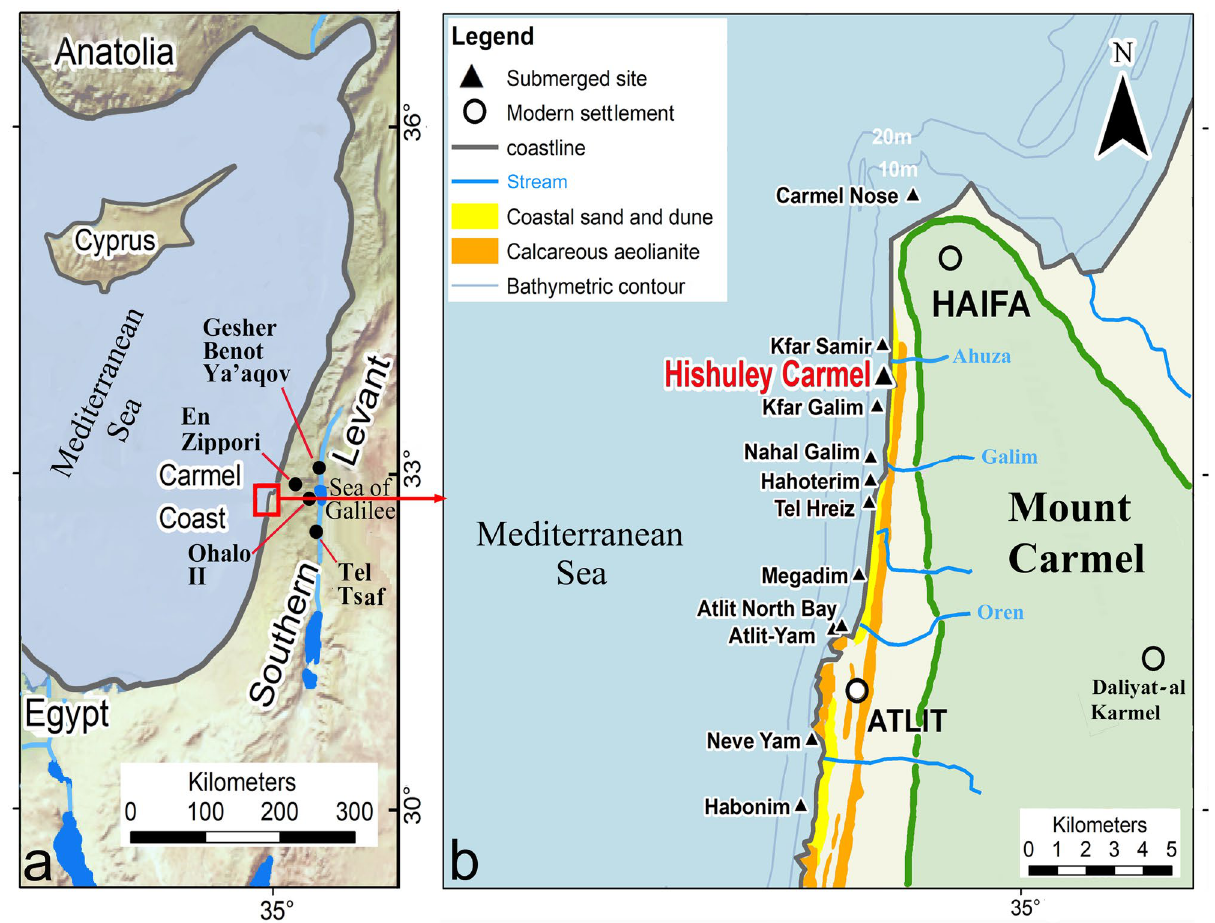
Figure 1. Location maps: ( a ) The Eastern Mediterranean and Southern Levant, and some sites mentioned in the text; ( b ) the Carmel coast and the submerged sites. Figures 1a, 1b were drawn by J. McCarthy after Natural Earth (https ://www.natur alear thdat a.com in the public domain). The two maps were modified by E. Galili using Adobe Photoshop CC